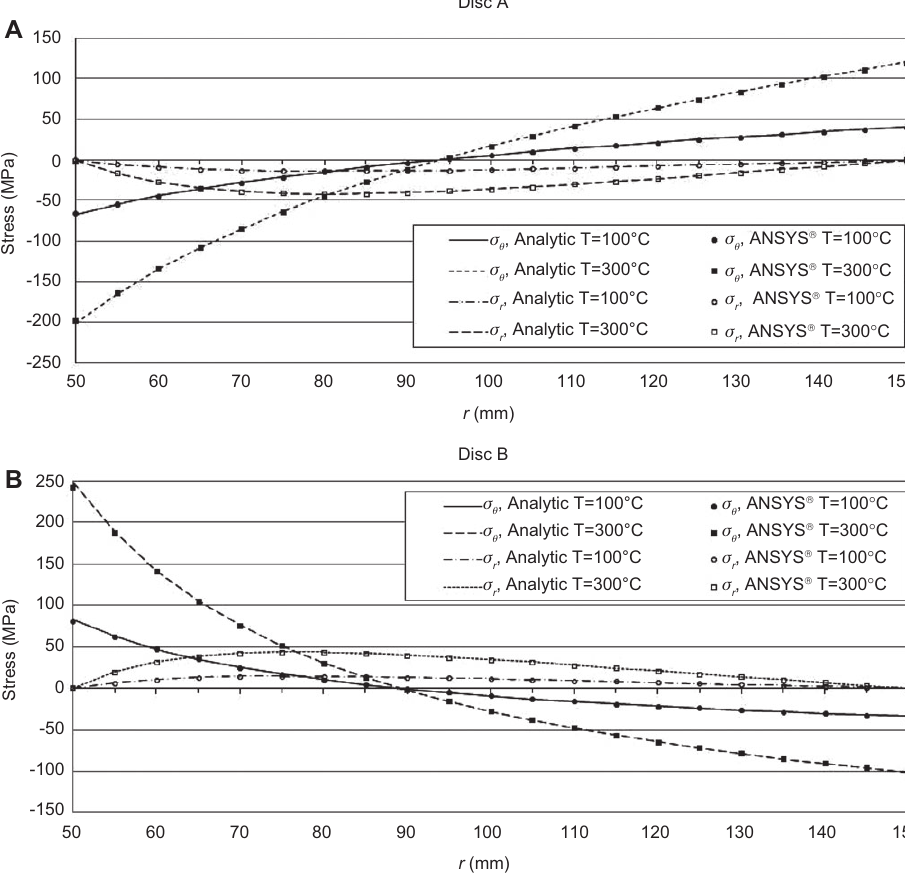
Figure 5 Variations of tangential and radial stresses at Disc A (A) and Disc B (B) under uniform